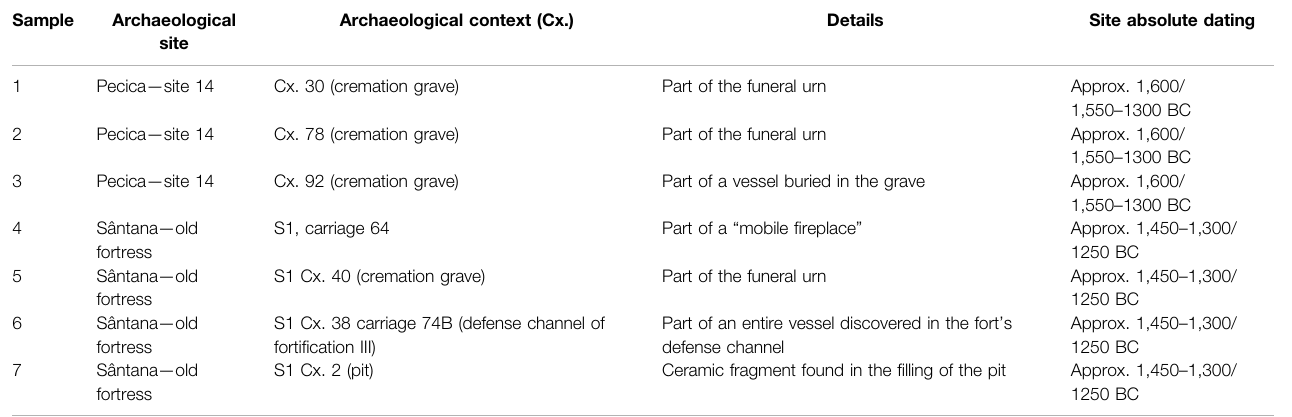
TABLE 1 | Characteristics of the analyzed ceramic